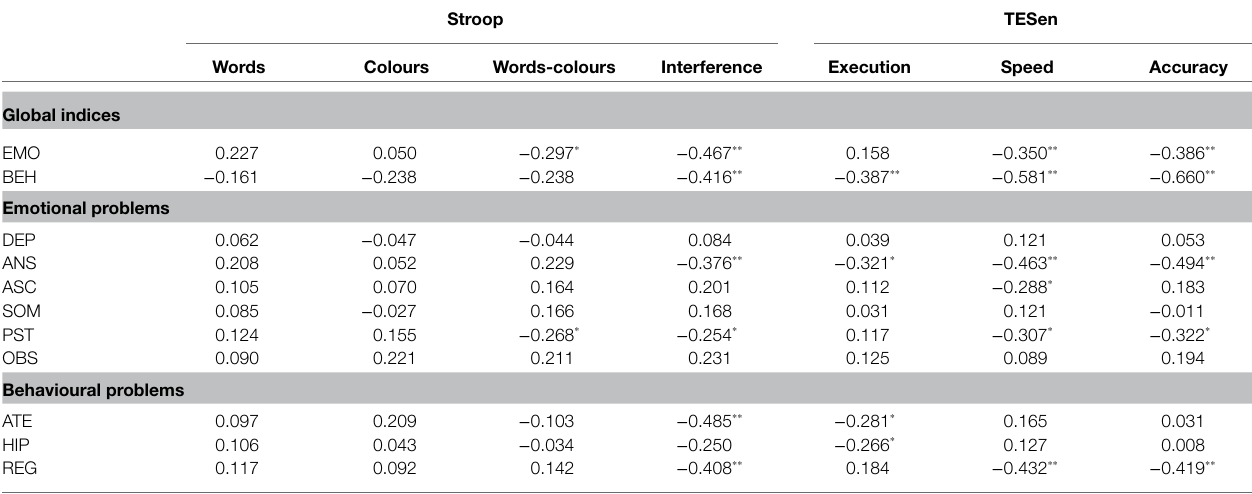
TABLE 3 | Correlation analysis between the executive processes, emotional problems, and behavioural problems. Stroop